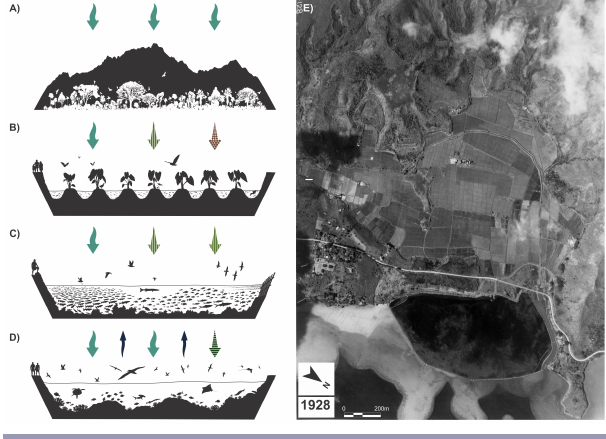
pond and nearby coastal ocean enhance water quality and species management (via recruitment), also resulting in a healthy coral reef environment. (E) A 1928 aerial photograph of the ahupua ʻ a of He ʻ eia (Ko ʻ olaupoko, O ʻ ahu). Photo credit: